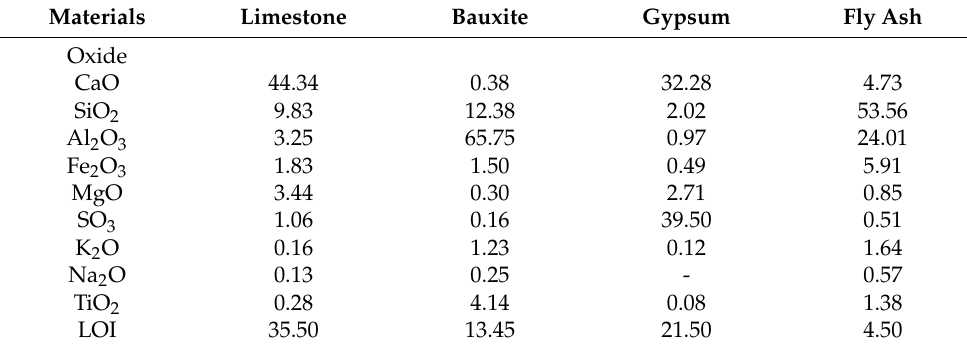
Table 1. Chemical composition of the raw materials determined by XRF (wt.%).